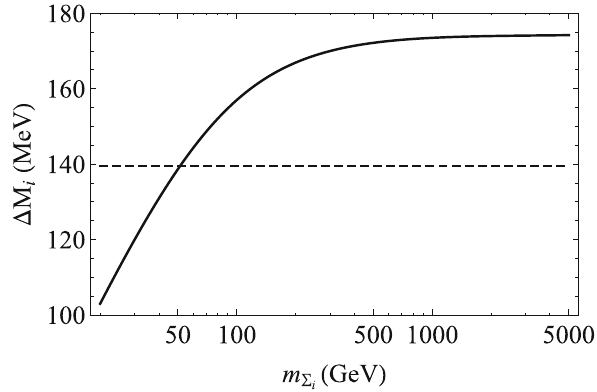
Fig. 1 The mass-splitting between (cid:2) ± and (cid:2) 0 induced by radiative corrections as a function of m (cid:2) . Dashed line denotes the π meson mass